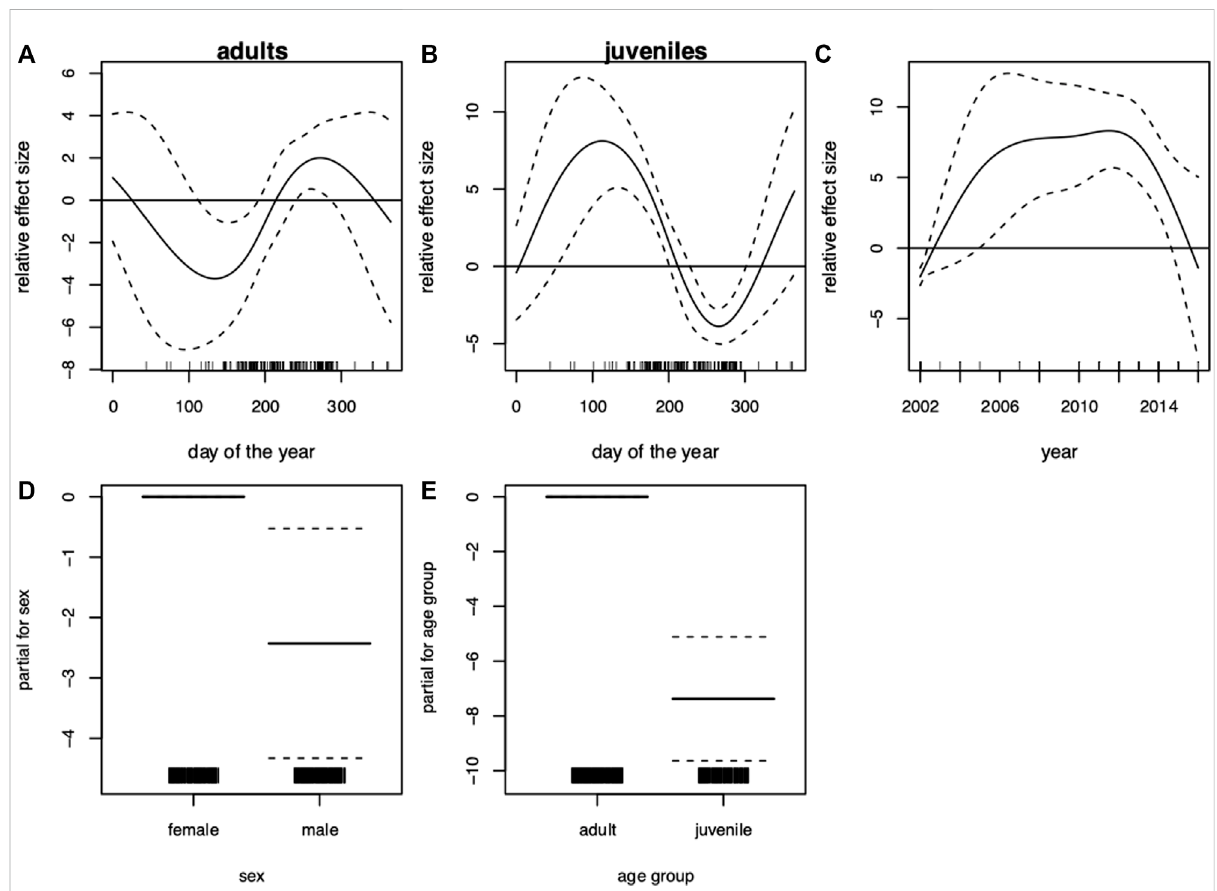
FIGURE 2 Harbor seal ( Phoca vitulina ), South-western Baltic Sea (incl. Kattegat). Generalized additive model (GAM) of blubber thickness showing the seasonal dependency (day of the year 1 – 365) conditional on age group (A) adults, (B) juveniles (present and previous years offspring) and the development over the (C) years. Moreover, the parametric terms of (D) sex and (E) age group. The y -axes represent the term ’ s spline function (solid line).Zeroonthe y -axescorrespondstonoeffectofthepredictorvariable.Thedottedlinesre fl ecttwotimestheSEbands(i.e.,95%con fi dence interval). Hatch marks on the x -axes show sample values and ranges. Deviance explained = 40.9%, n =